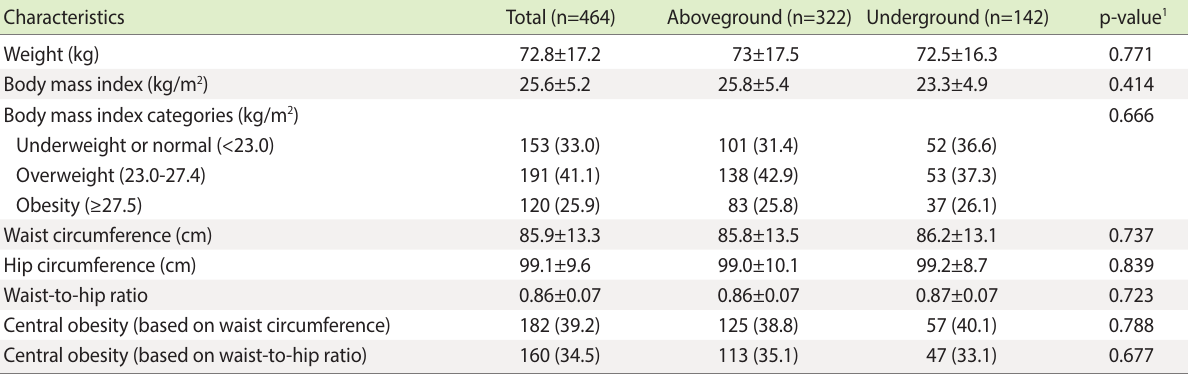
Table 4. Anthropometric and clinical measurements of the study cohort at baseline Characteristics